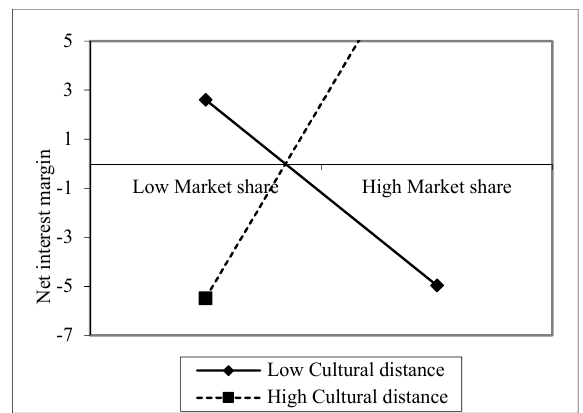
Figure 5. Market Share × Cultural Distance.